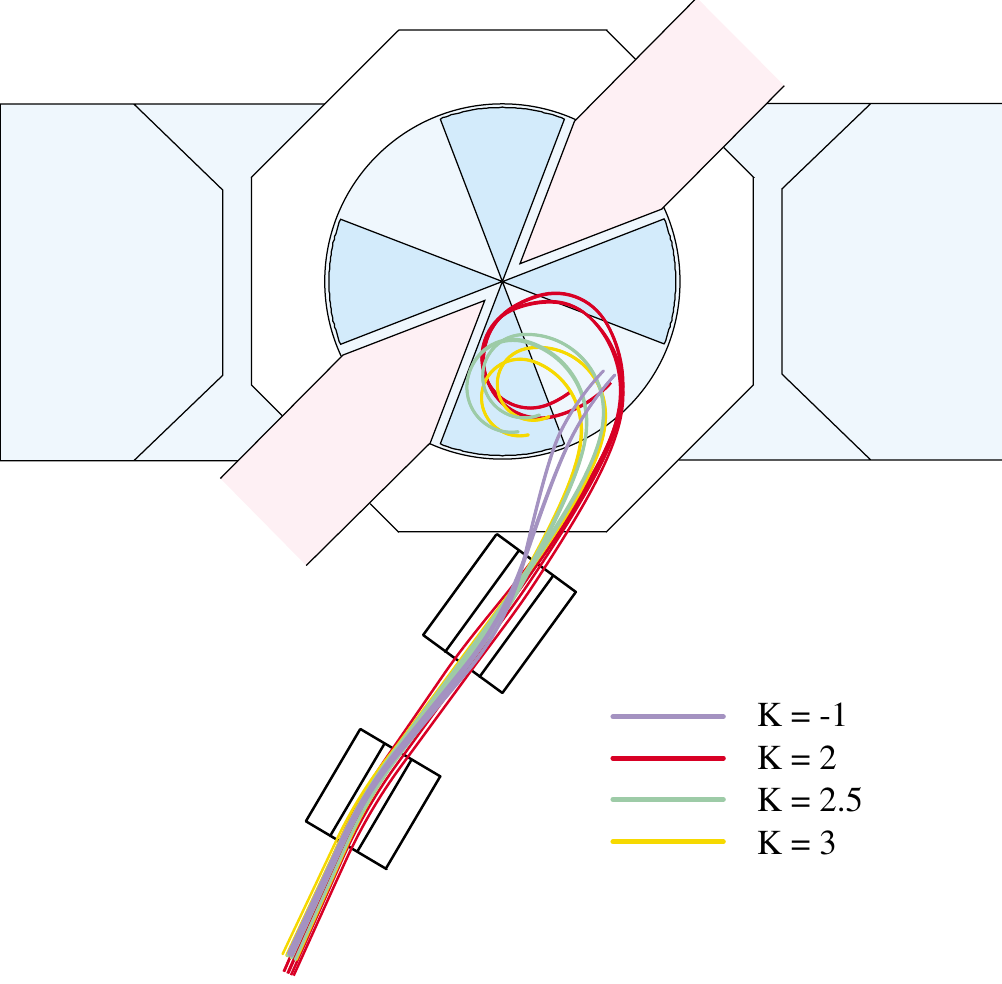
FIG. 6. (Color) Horizontal layout of test beams and beam-guiding elements. A test beam is represented by its central ion trajectory and horizontal envelope. For each K , the two test beams, corresponding to the minimum and the maximum R beam-guiding elements of the extraction system, namely, the combined magnet, CM, and the bending magnet, BM, are represented by their placements and lengths, horizontal apertures, and estimated widths. The depicted magnet apertures represent 125% of the minimal apertures that enable all the test beams to pass through the magnets without collision. Note that the beams with K (cid:4) (cid:2) 1 (cid:4) 4 (cid:1) , not (cid:6) (cid:4) 6 (cid:1) . The trajectory offset of these highly bent beams enabled the decrease of the horizontal have the exit point (cid:6) e e aperture of the combined magnet. In the case of the bending magnet, the horizontal aperture decrease was achieved by shifting the magnet center with respect to the beginning of the high-energy transport